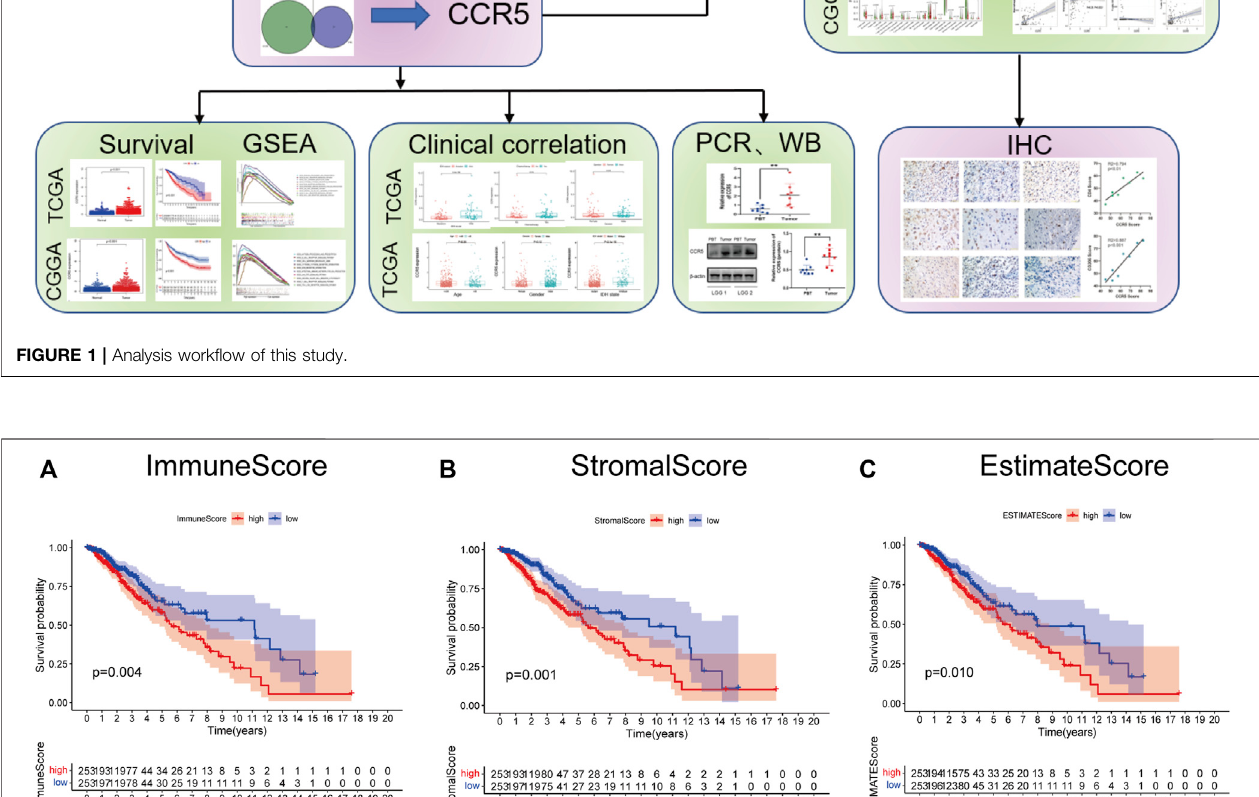
Frontiers in Genetics |